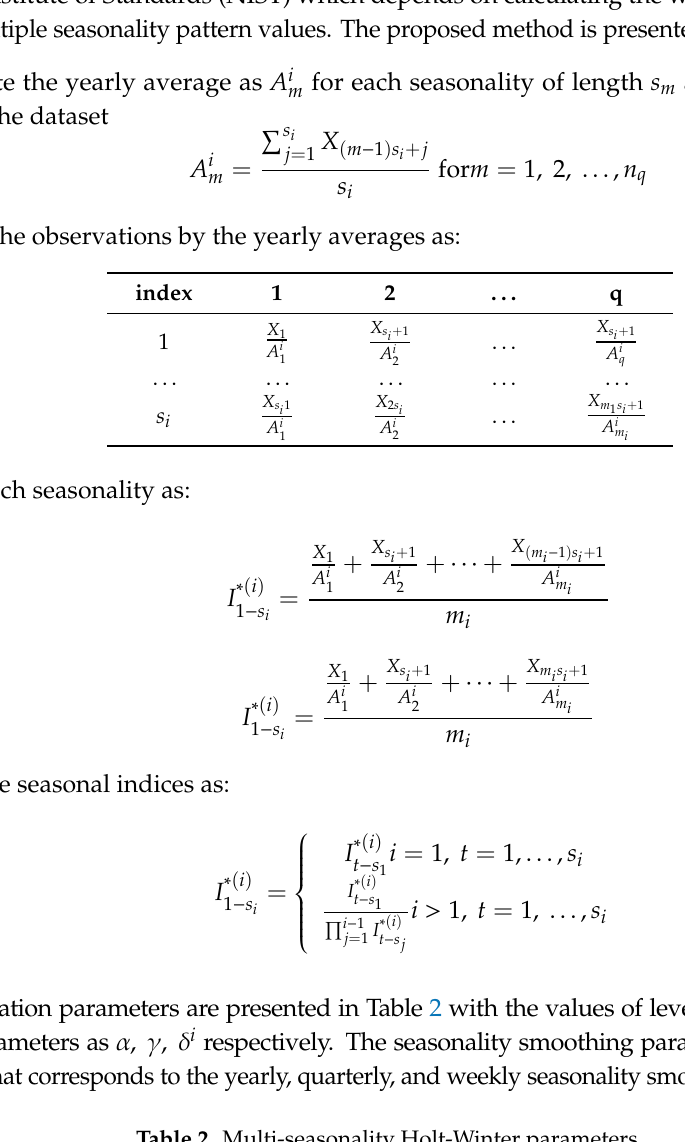
Table 2. Multi-seasonality Holt-Winter